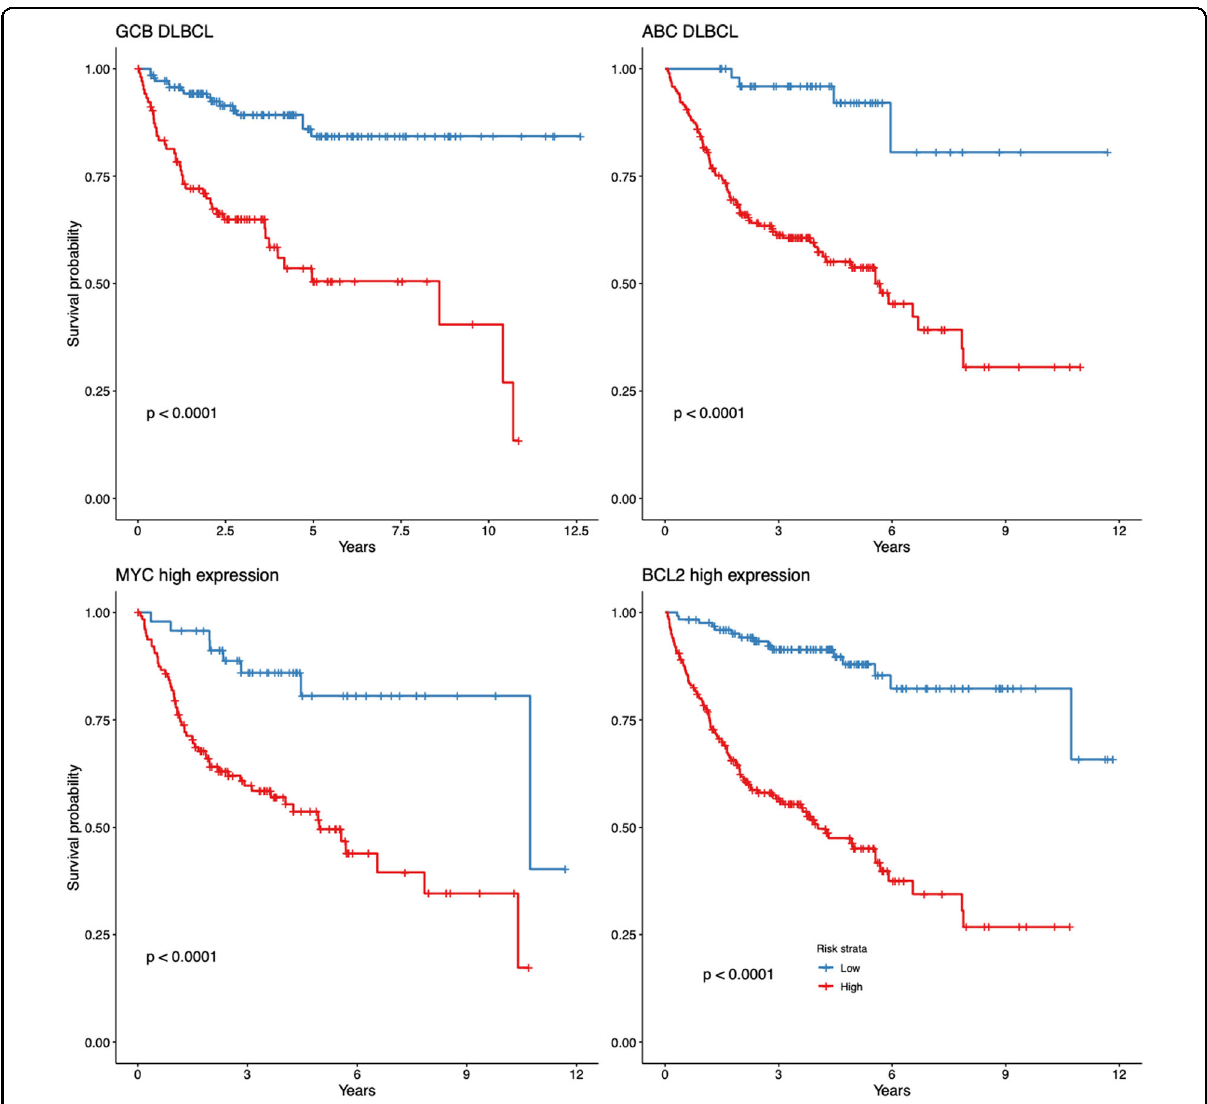
Fig. 4 Gene Expression-Based Survival Model. The gene expression-based survival model signi fi cantly strati fi es survival within ABC and GCB subtypes, and MYC and BCL2 high-expression groups (log-rank